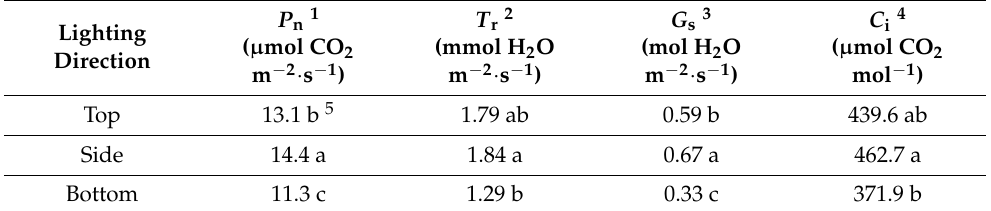
Table 2. Influence of the lighting direction on the photosynthetic characteristics of strawberries grown for 45 days.